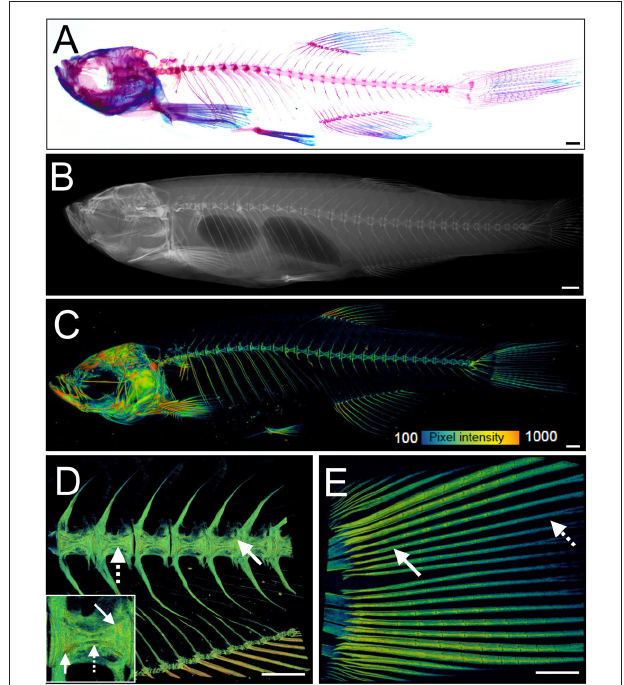
FIGURE 3 | Examples of visualization and quantification of mineralized bone in zebrafish. (A) Wholemount Alizarin Red S (AR) and Alcian Blue staining of 3 months fixed fish. (B) Radiograph of 1-year old live fish showing whole body: endo- and exoskeleton. (C) Low resolution µ CT images acquired with a 20 µ m voxel size of a 3 months old fish. Note that pixel intensity can be used to determine BMD; represented on the color coded pixel intensity bar. (D,E) High resolution (5 µ m voxel size) µ CT images of vertebral column with anal fin rays (D) and caudal fin rays (E) . Vertebral centrae have higher density at their edges (solid arrow) than the center (dashed arrow). In the fin rays, a higher density (solid arrow) is observed in older segments within the proximity to the body in comparison to younger segments located more caudally showing lower pixel intensity (dashed arrow). The same pixel intensity color coding as (C) applies. All fish and their insets are depicted from a lateral view in an anterior-posterior (left-right) orientation. Scale bars = 50 µ m in (A,B) ; and 100 µ m in (C–E)